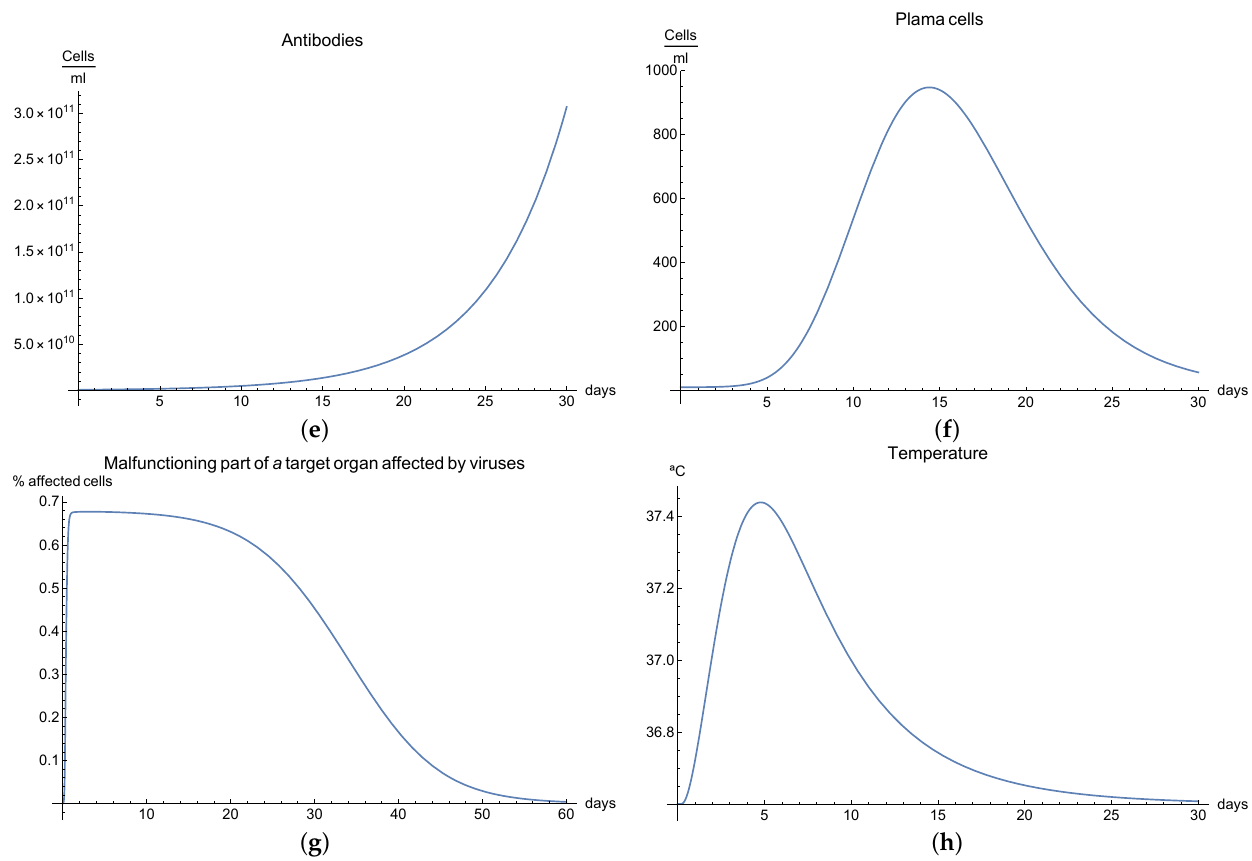
Figure 4. Numerical results of the mathematical model for the case in which the immunophysiological response of COVID-19 infection when immunotherapy using antibodies is applied: ( a ) the viral load V ( t ) , ( b ) the cytotoxic T-lymphocytes T e ( t ) , ( c ) the B-lymphocytes B ( t ) , ( d ) the class 1 helper T-lymphocytes class 1 T H 1 ( t ) , ( e ) the antibodies A ( t ) , ( f ) the plasma cells P ( t ) , ( g ) the malfunctioning part of a target organ affected by viruses m ( t ) , and ( h ) body temperature θ ( t ) . In all cases, the numerical results are simulated when immunotherapy using antibodies is